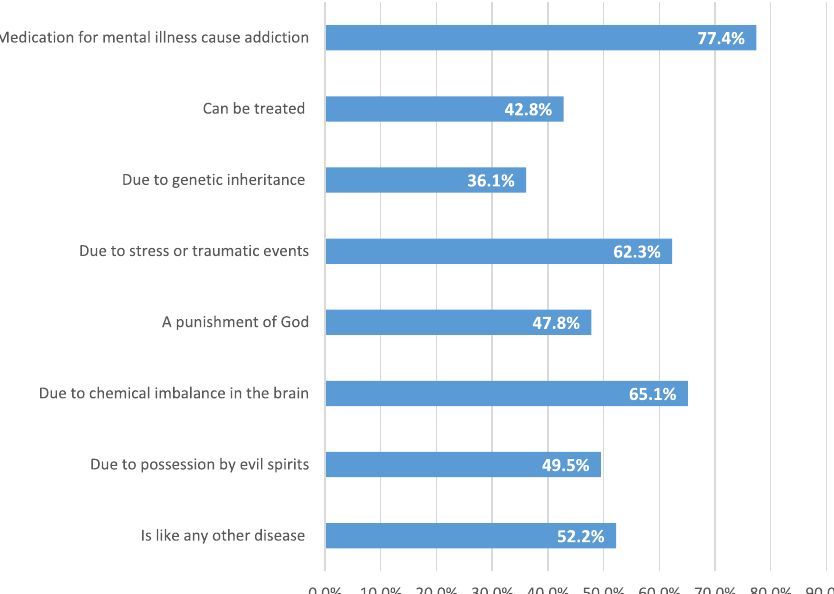
Fig. 1 Beliefs towards mental illness among the studied